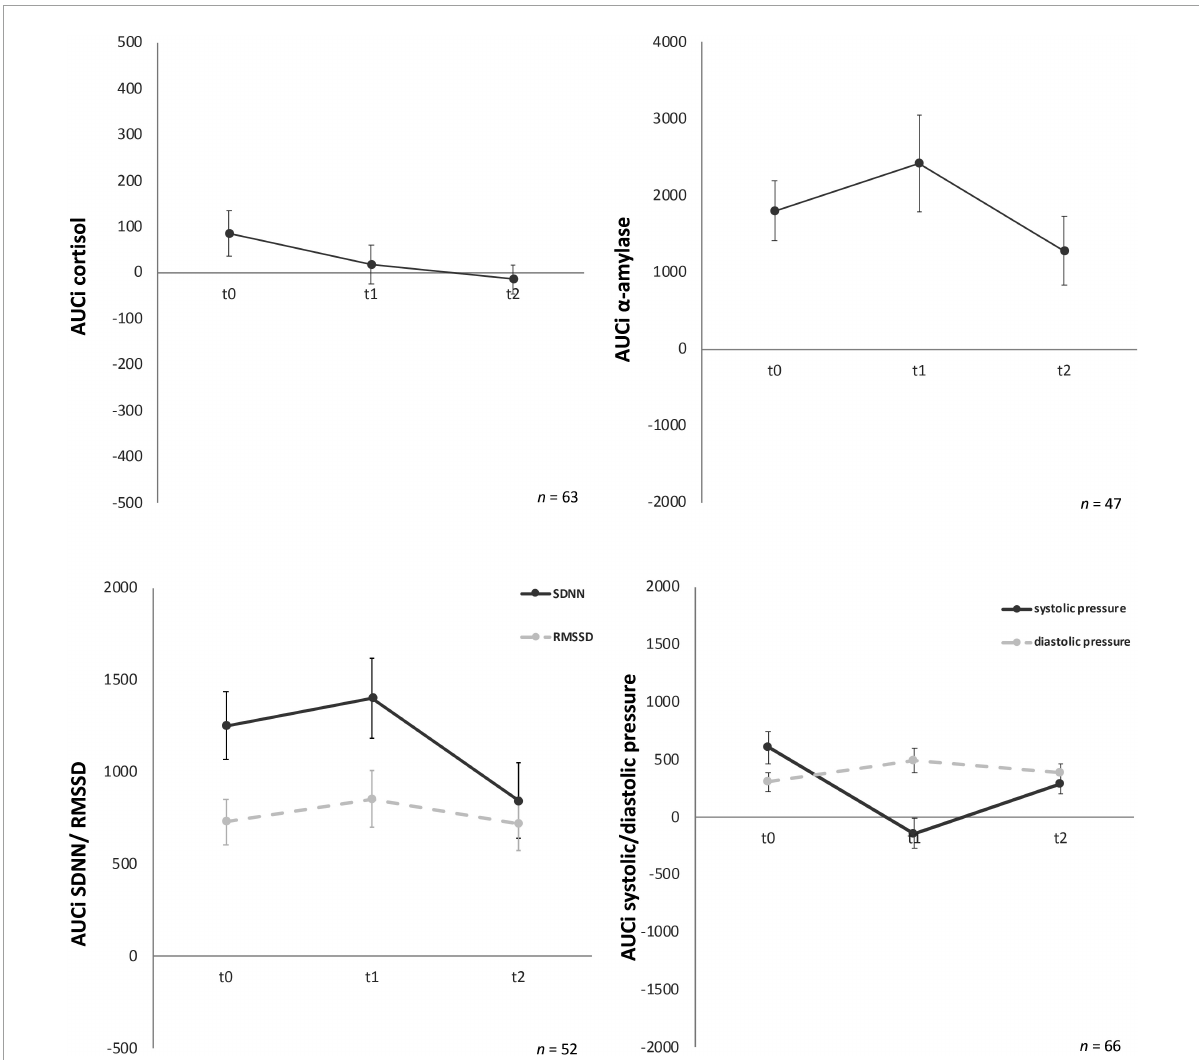
FIGURE3 Stress response of cortisol, α -amylase, standard deviation of all normal-to-normal inter-beat intervals (SDNN) and root mean square of successive differences between normal-to-normal inter-beat intervals (RMSSD), systolic and diastolic pressure for the three time points (t0, t1, t2). Y-axis values: AUCi, area under the curve with respect to increase for cortisol (nmol/l), amylase (U/ml), SDNN/RMSSD (ms), systolic/diastolic pressure (mm/Hg). Values are means ( ± SEM).